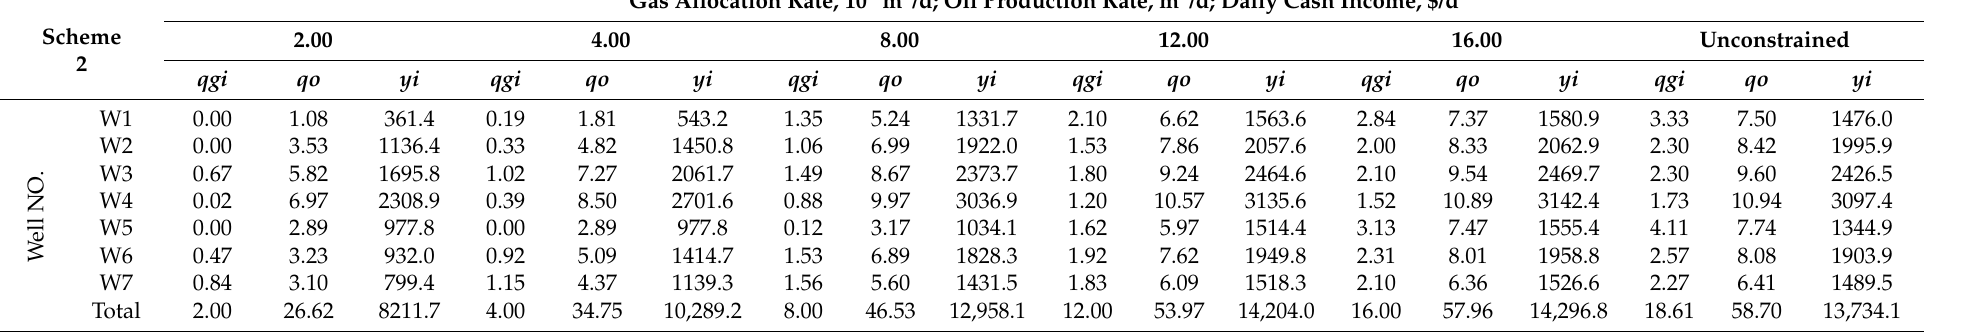
Table 5. Gas allocation result of various total injected gas rate of Scheme